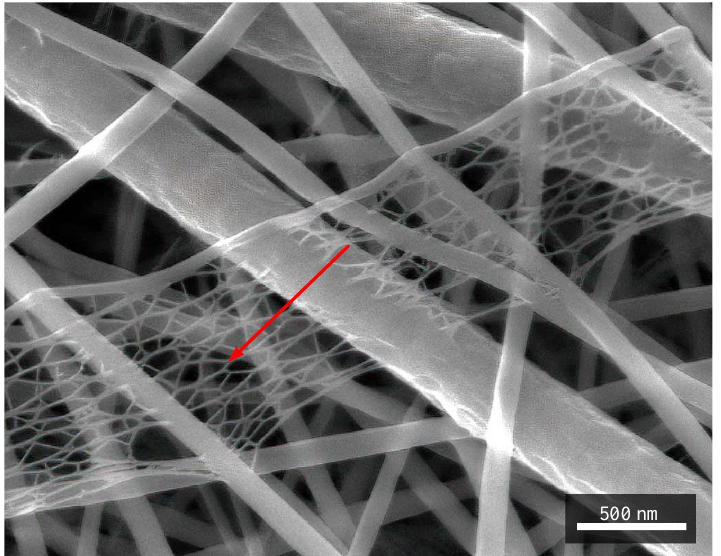
Figure 4. A structure of porous character resembling a cobweb. This structure was observed in combination with nylon-6 (PA6) [61]. The structures of smaller nanofibers within tens of nanometers are indicated by the